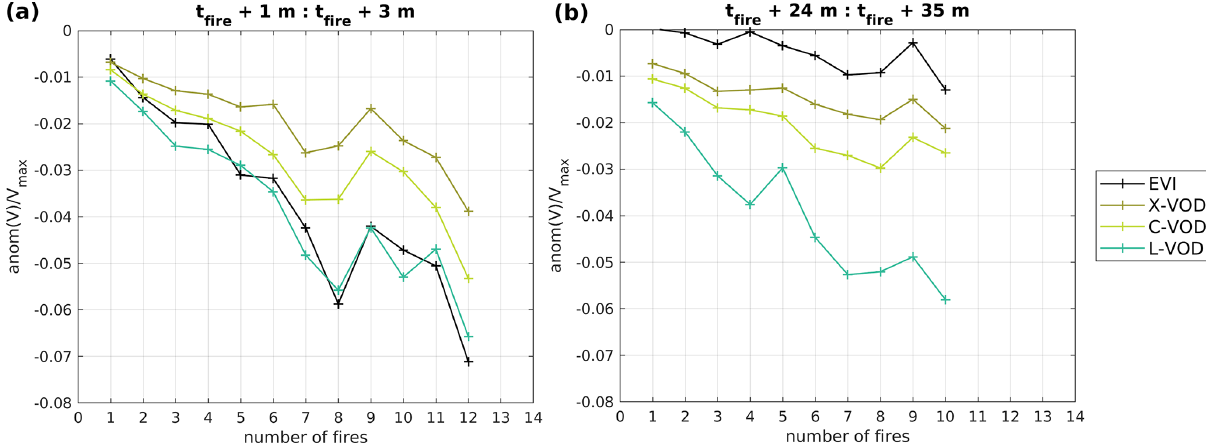
Figure 8. Anomalies of vegetation variables ( V ) averaged (a) from 1 to 3 months post-fire and (b) from 24 to 35 months post-fire, with respect to the number of fires by pixel (MODIS), for dense broadleaf forests only. The anomalies were normalized with the 99th quantile of each variable V max (EVI max = 0 . 60, X-VOD max = 1 . 03, C-VOD max = 1 . 20, and L-VOD max = 1 .